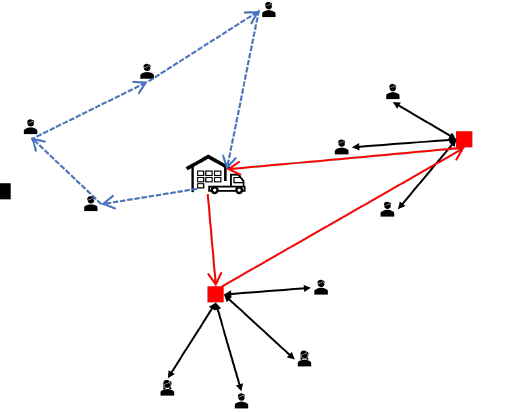
Figure 4. Example derived from Instance 7 from Table 5 with service cost of the